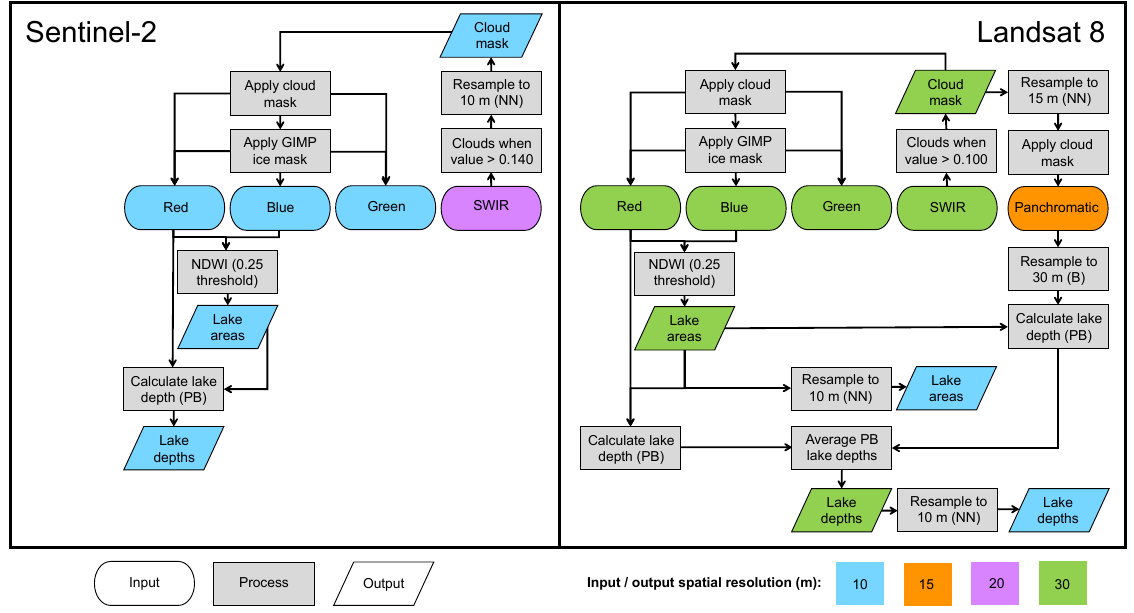
Figure 2. Summary of the methods applied to the Sentinel-2 and Landsat 8 input data to calculate lake areas using the NDWI and depths using the physically based (“PB” in this figure) method. In this figure, the interpolation techniques used are indicated by “NN” for nearest neighbour or “B” for bilinear. The methods applied to Landsat 8 are shown only once the images had been reprojected and batch cropped to the same extent as the Sentinel-2 images (Sect. 2.2.1). The lake area outputs are compared between the two datasets as described in Sect. 2.3, and the physically based lake depth outputs are compared as outlined in Sect. 2.4. When the empirical lake depth method for calculating Sentinel-2 lake depths was also evaluated, the final Landsat 8 depths at 10m resolution were directly compared against the original Sentinel-2 input band data (at native 10m resolution) within the lake outlines defined with the